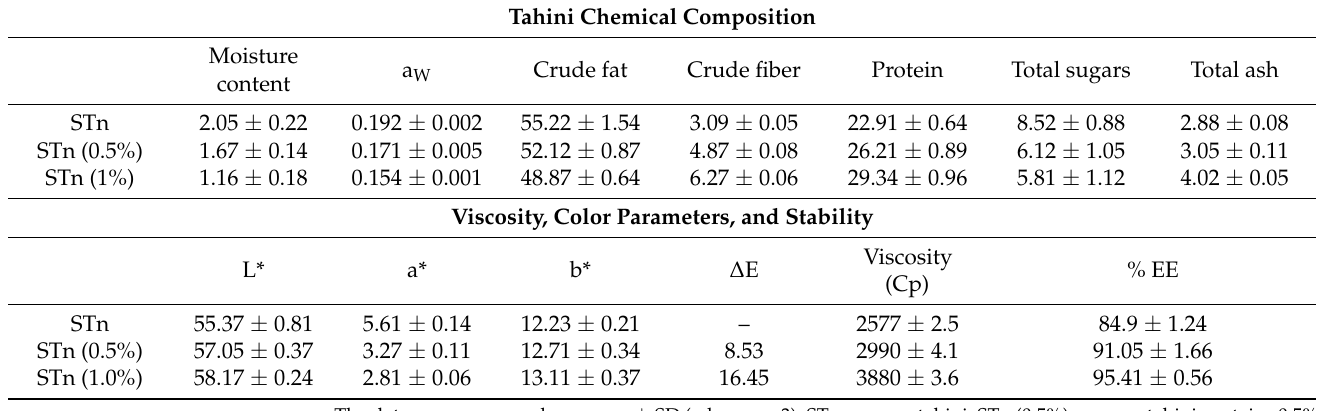
Table 3. Chemical composition and rheological changes of sesame tahini after Agaricus blazei fortification. Tahini Chemical